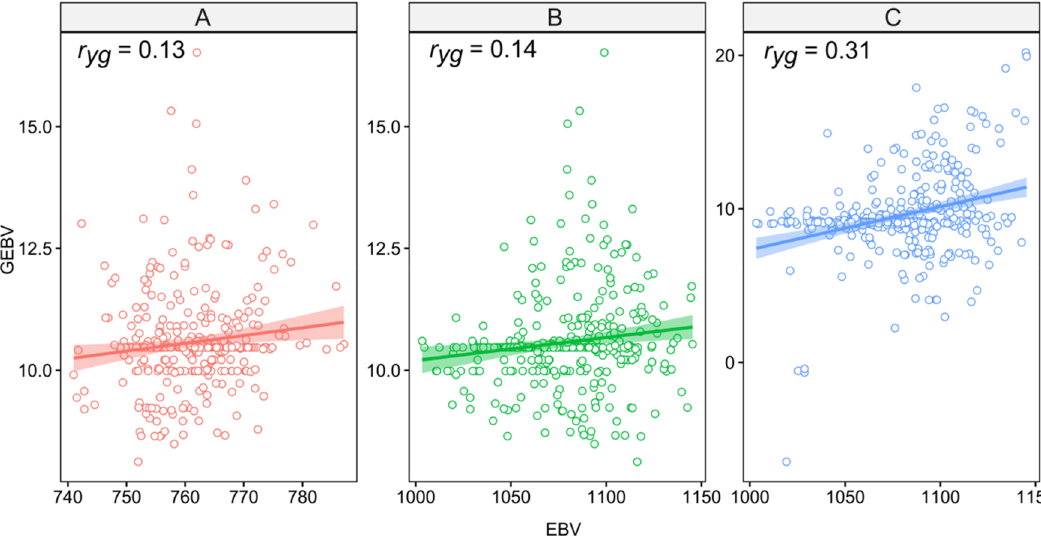
Figure 2. Accuracy of estimated prediction models in crop 1 validated in crop 2 ( A ), crop 1 validated in crop 3 ( B ), and crop 2 validated in crop 3 ( C ). The package used of R to create this Figure was ggplot2 (v0.3.3, https:// cran.r- proje ct. org/ web/ packa ges/ ggplo t2/ index.